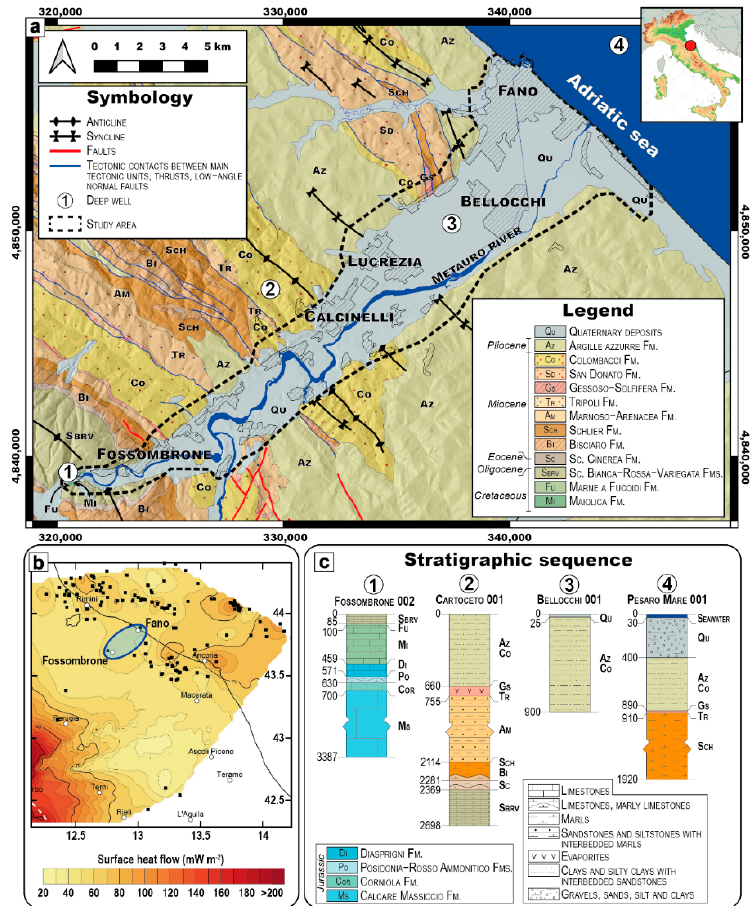
Figure 1. ( a ) Simplified geological map of the lower Metauro Valley and surrounding areas with the main cities (modified after Conti et al. [34]); ( b ) surface heat flow map of central-eastern Italy with 10 mW m − 2 isolines; black squares indicate the wells, white circles the cities and the blue ellipse the study area (modified after Pauselli et al. [29]); ( c ) schematic stratigraphic sequence and lithologies obtained from four deep boreholes of the Visibility of Petroleum Exploration data in Italy (VIDEPI) project [39].